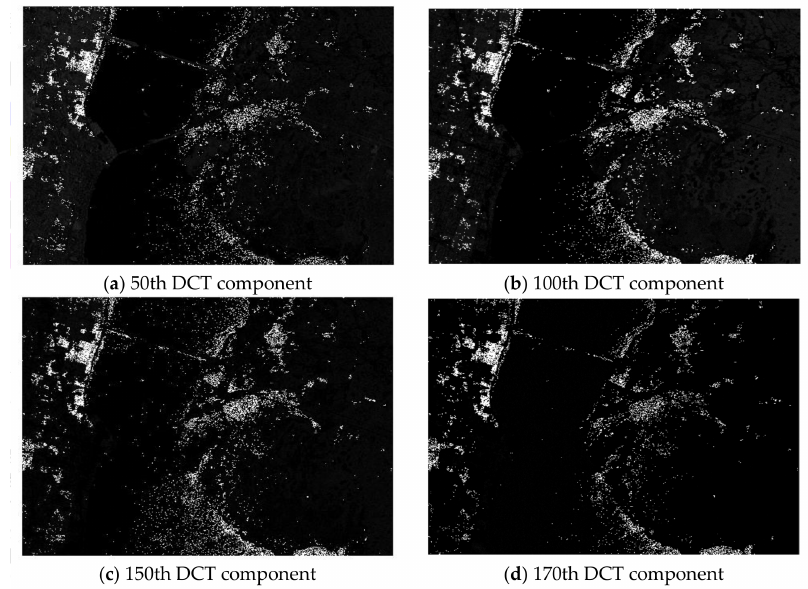
Figure 3. Four transformed high-frequency components of the spectral-DCT feature space from the Kennedy Space Center dataset.